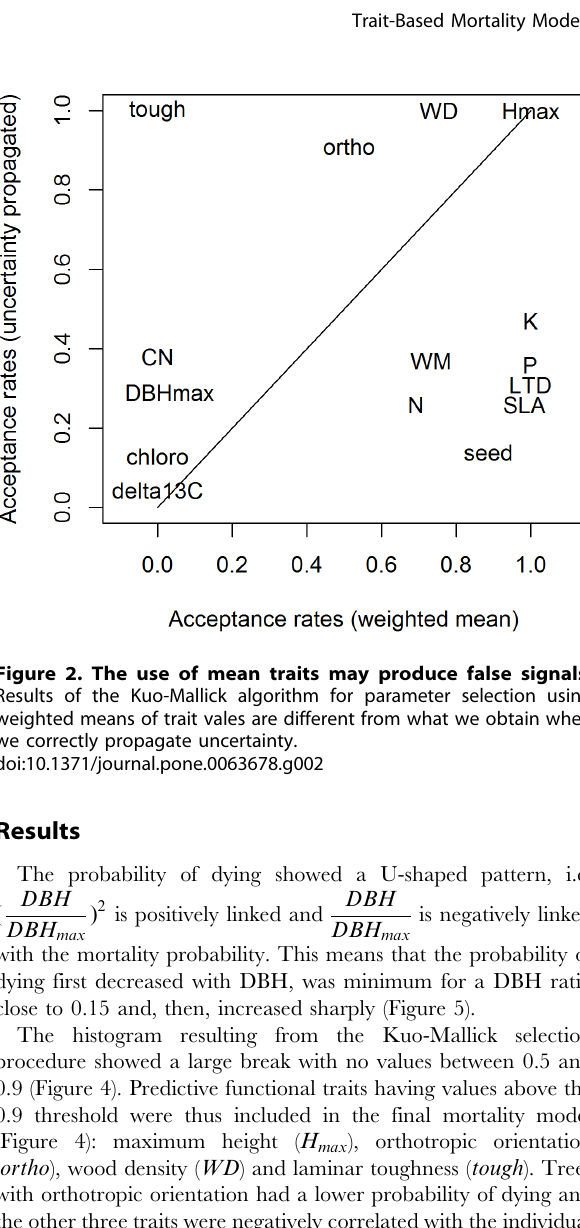
(Figure 4): maximum height ( H max ), orthotropic orientation ( ortho ), wood density ( WD ) and laminar toughness ( tough ). Trees